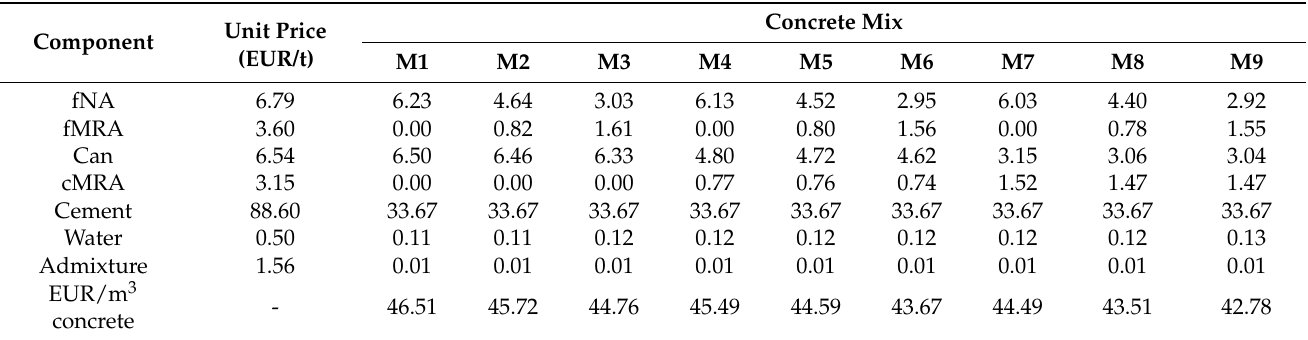
Table 9. Manufacturing cost of the mixes